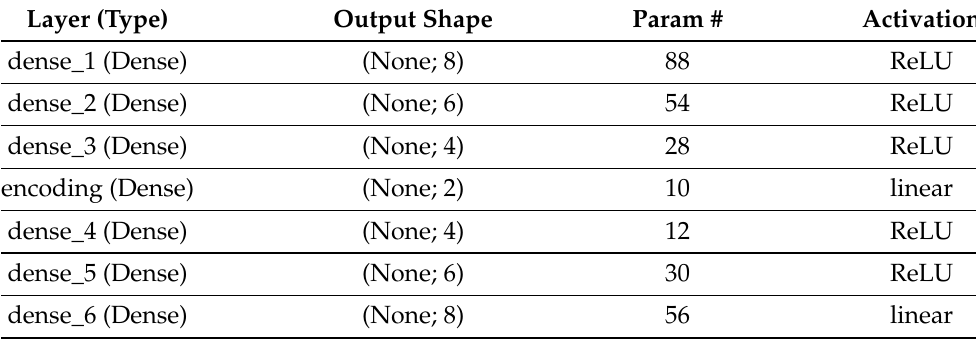
Table 4. Architecture of the AE used for the data sets from the 2020–2021 academic year.